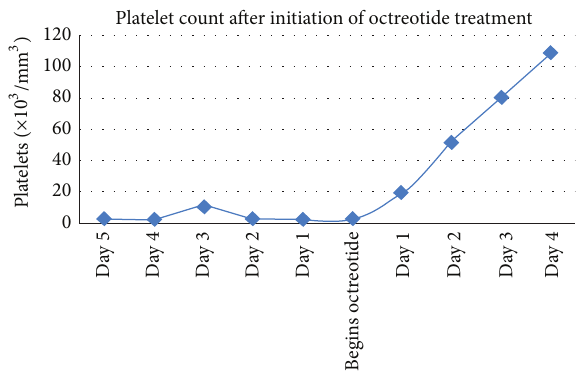
Figure 6: Platelet count after initiation of octreotide treatment.